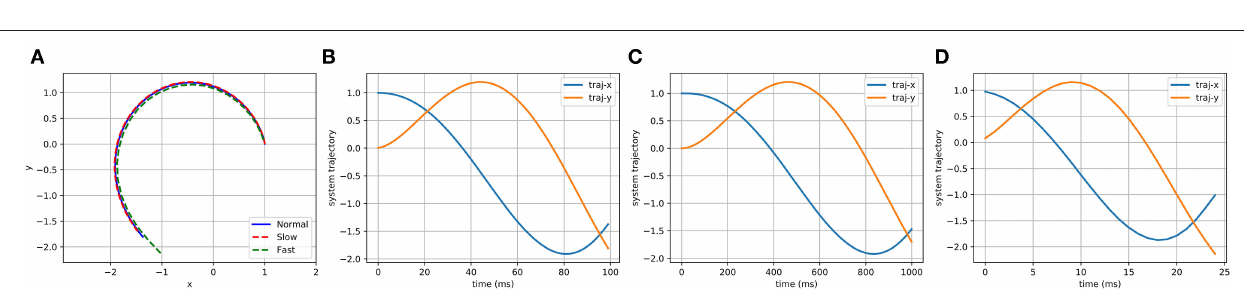
in which, c i is the center of the function, h i is the height, and w i